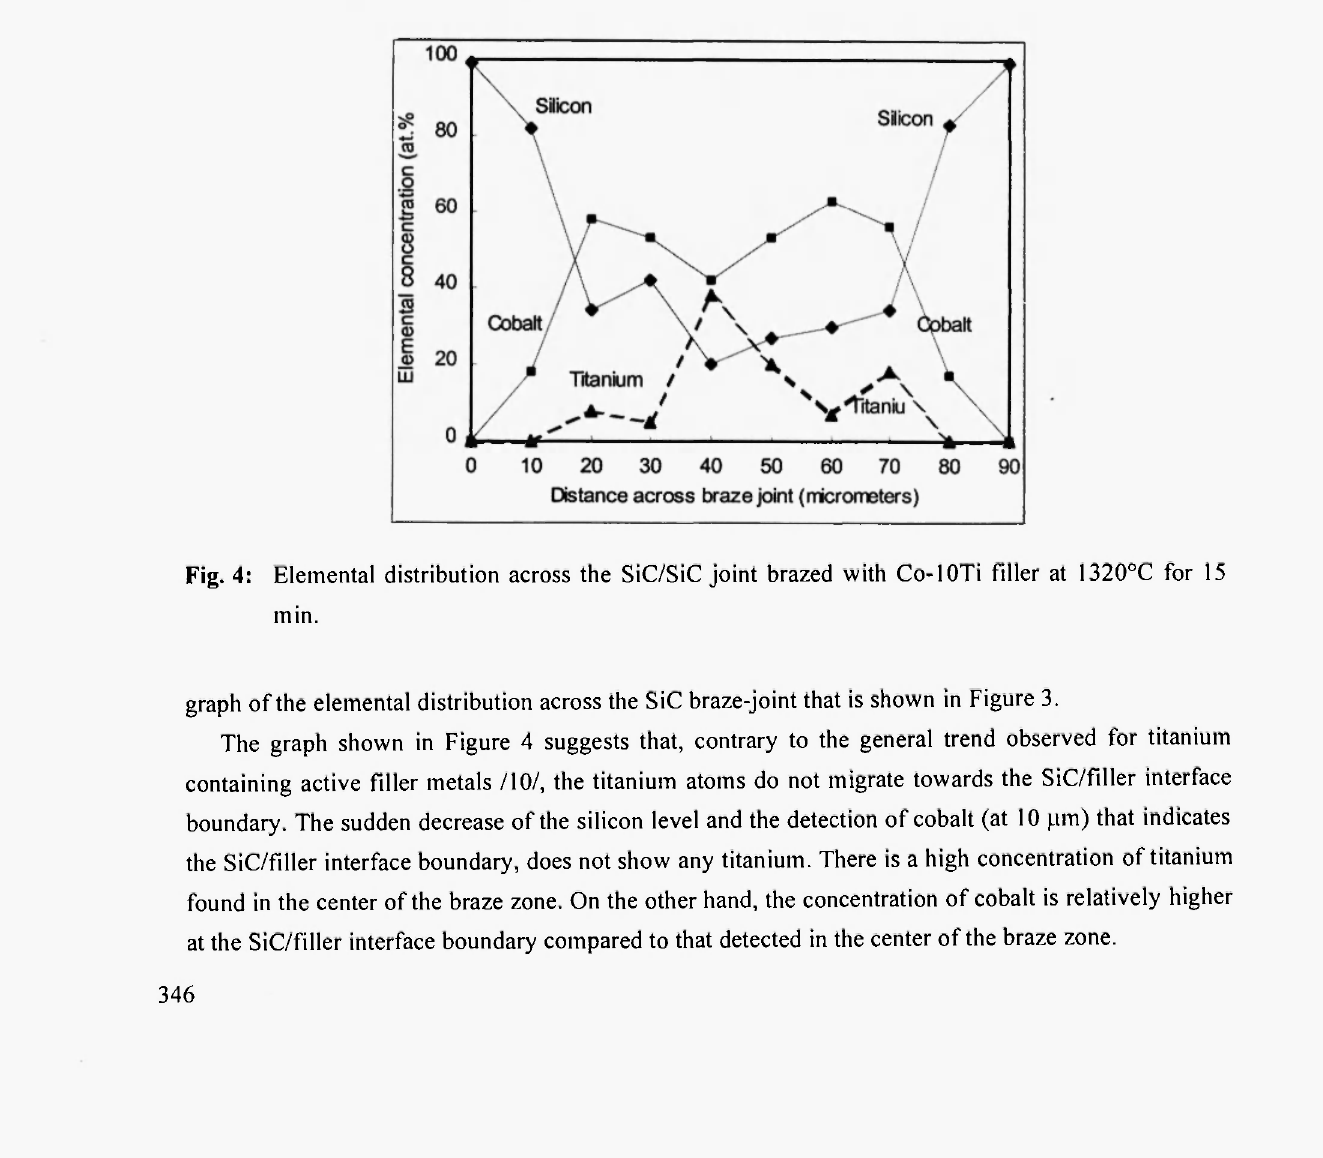
Fig. 3: SiC joint brazed using Co-10Ti filler metal at 1320°C for 15 minutes in vacuum. SEI micrograph.